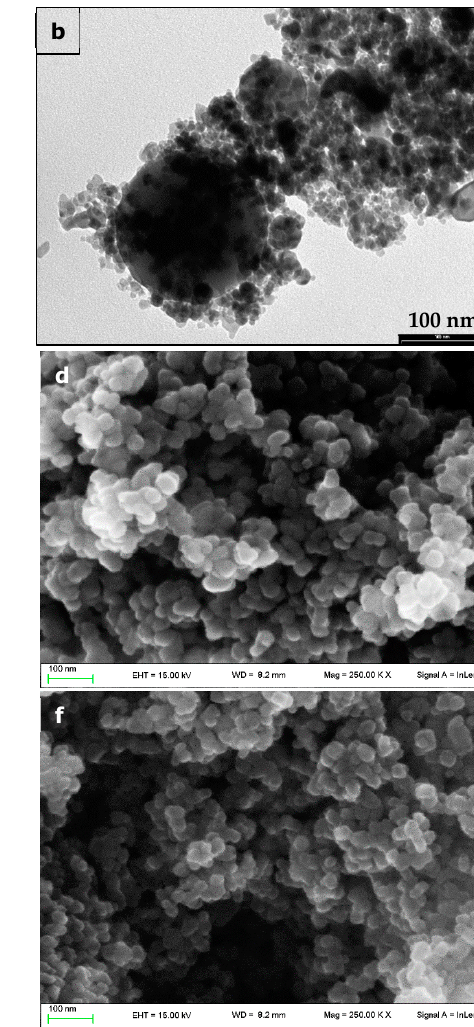
active materials. The raw data were elaborated according to the Tauc plot method, cor-